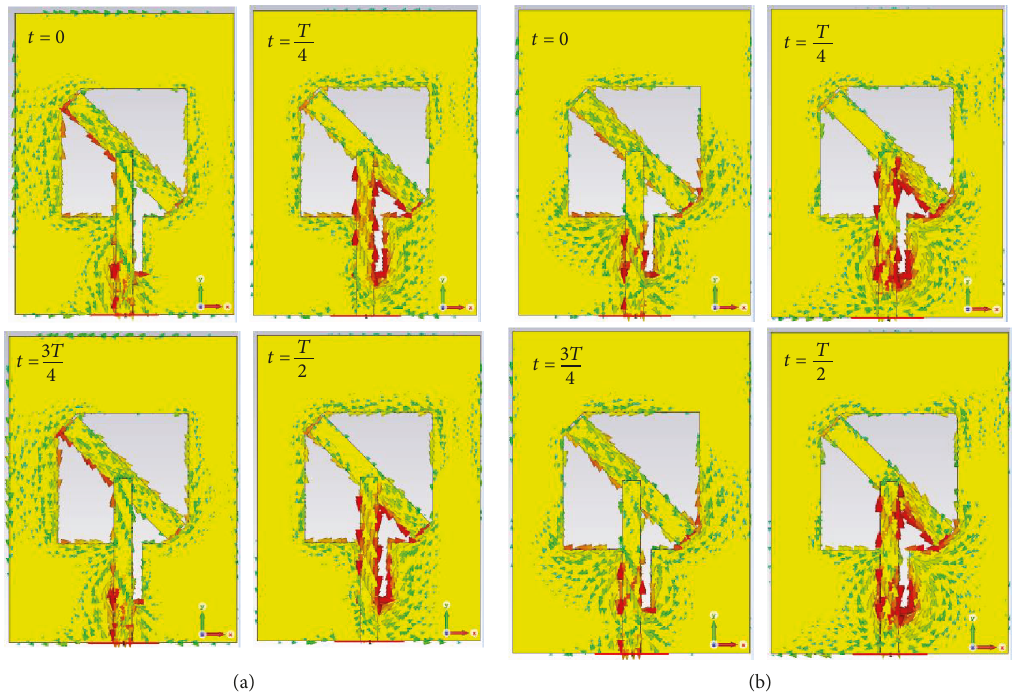
Figure 13: The current vector distributions of the proposed WLAN-enabled antenna (front view): (a) 2.45GHz and (b) 5.80 GHz.